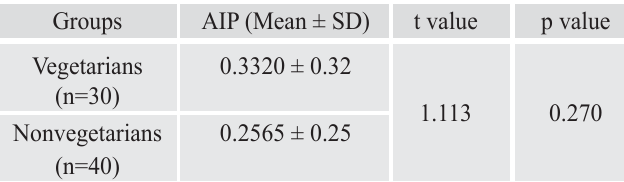
Table II: Comparison of AIP between vegetarians and nonvegetarians